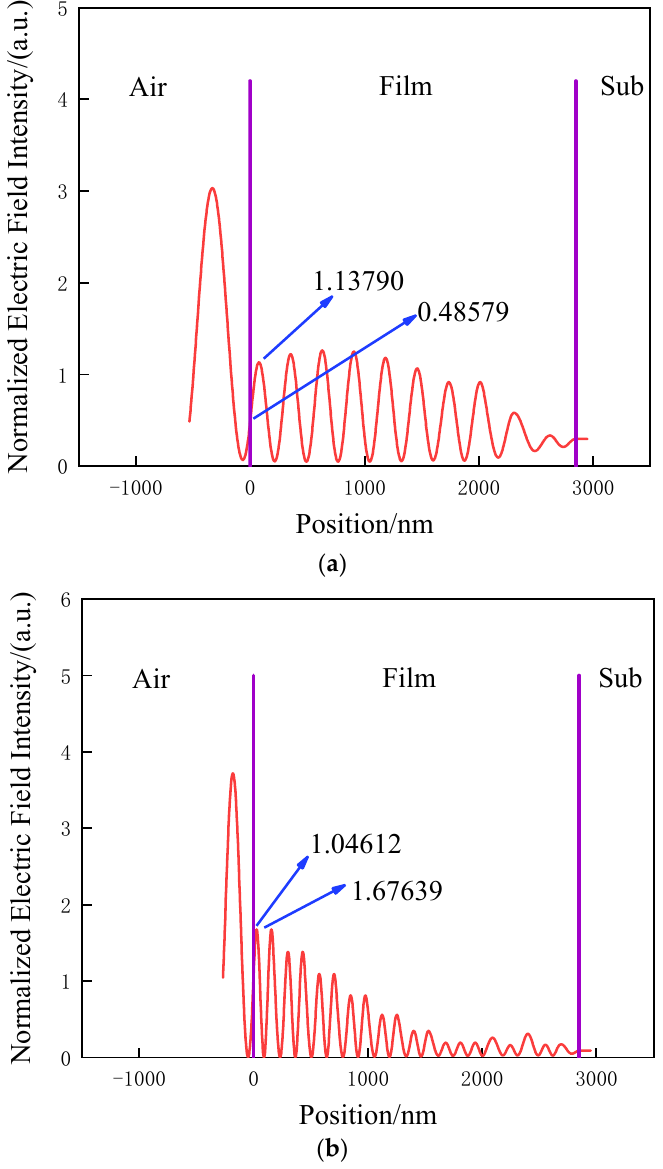
Figure 5. Relative standing-wave electric field intensity distribution of the non-regularized highly reflective TiO 2 /SiO 2 film at ( a ) 1064 nm and ( b ) 532 nm ( The red line indicates the simulated electric field strength of the film, the purple line at the air-film interface indicates the film surface location, and the purple line at the film-substrate interface indicates the film thickness location ; the value of the field strength at the interface between air and film is the interfacial electric field strength, and the first peak of the electric field strength inside the film is the peak electric field strength).